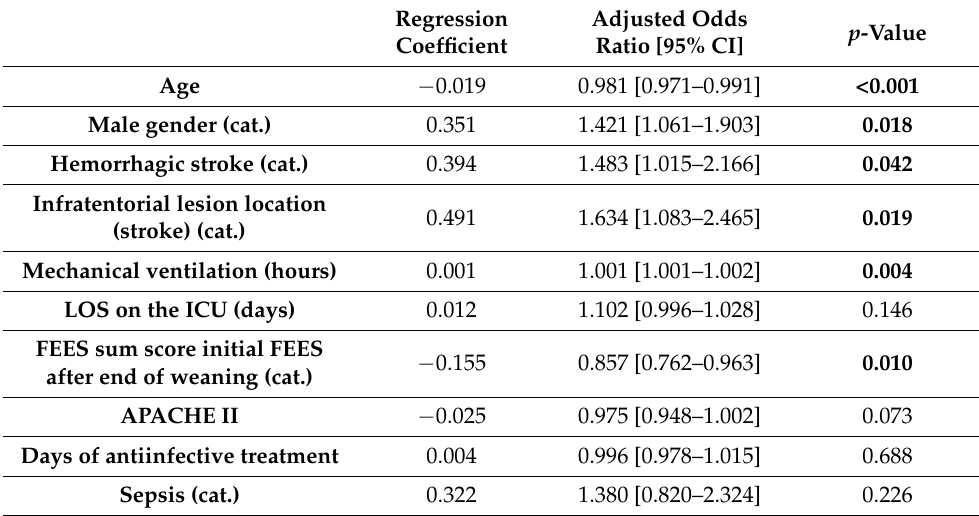
Figure 2. Days of gastric residual volume ≥ 500 mL/d, according to sum score on the first flexible endoscopic evaluation of swallowing (FEES) within 72 h of the conclusion of mechanical ventilation. Score 0: n = 360; Score 1: n = 146; Score 2: n = 173; Score 3: n = 297; GRV = gastric residual volume; mL = milliliters. Table 2. Multivariate binary logistic regression analysis; outcome variable: GRV ≥ 500 mL/d on at least one